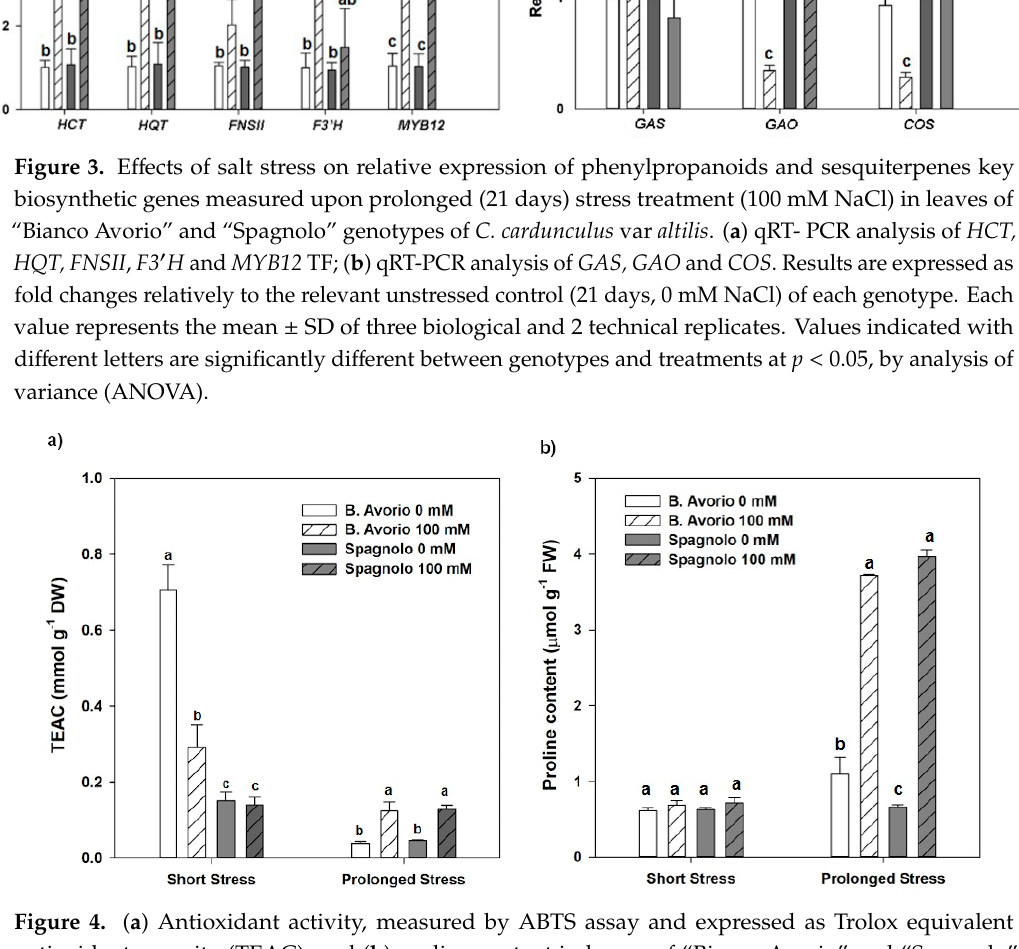
with different letters are significantly different between genotypes and treatments at p < 0.05, by analysis of variance (ANOVA).